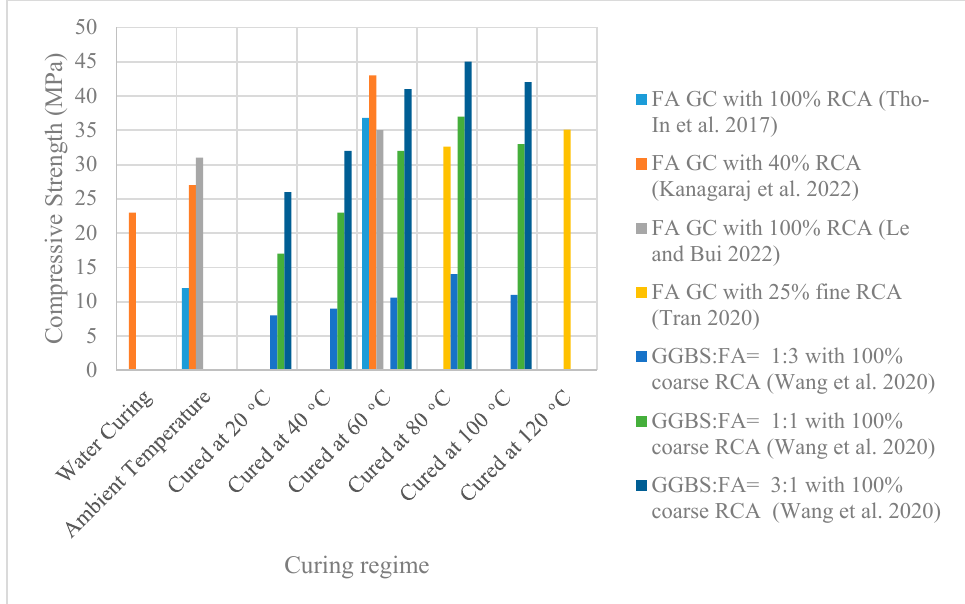
Figure 7. Effect of curing regime on CS [35,61,75,91,101].